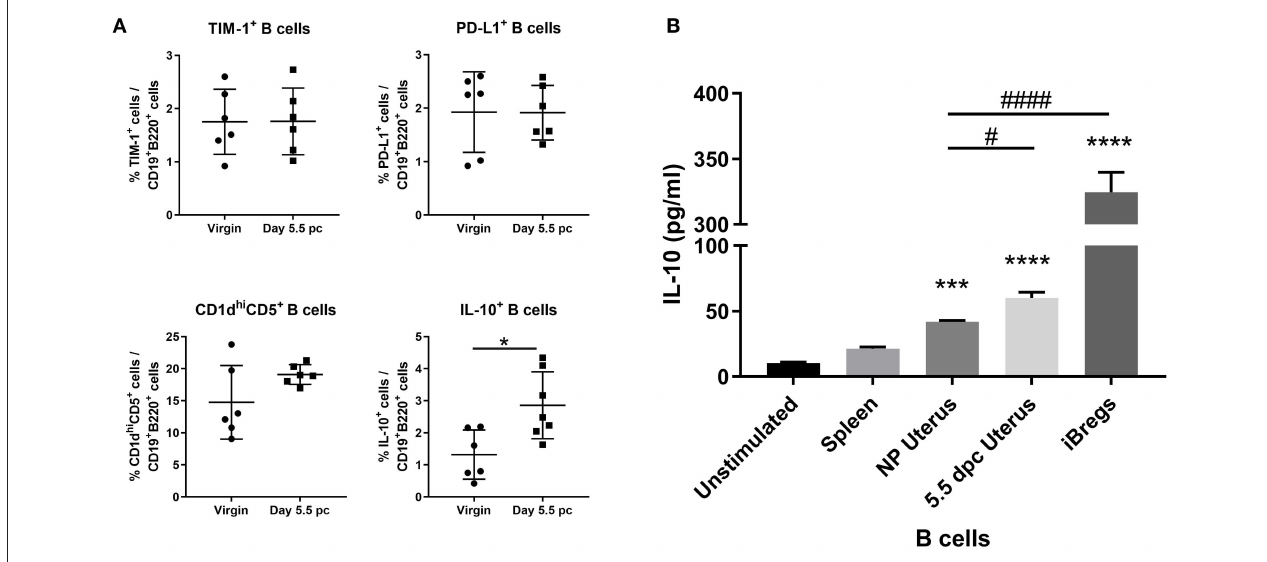
FIGURE 4 | An expanded pool of IL-10 + B cells are present in the uterus after implantation. (A) Known regulatory B cell subsets were analyzed from B cells collected from non-pregnant and pregnant uteri ( n = 6–7, unpaired t -test). (B) IL-10 production by stimulated populations of purified B cells obtained from the spleen, virgin uterus, day 5.5pc uterus, or in vitro induced Bregs was assessed by ELISA. Data represent pooled supernatants of duplicate wells from three independent experiments. Data is presented as mean ± SEM and compared by one-way ANOVA, followed by Dunnett’s post-hoc multiple comparisons test against unstimulated control. * p ≤ 0.05, *** p ≤ 0.001, **** p ≤ 0.0001. Additional Dunnett’s analysis assessed against non-pregnant virgin uterus reveal a significant increase in IL-10 produced by day 5.5pc uterine B cells and iBregs ( # p ≤ 0.05, #### p ≤